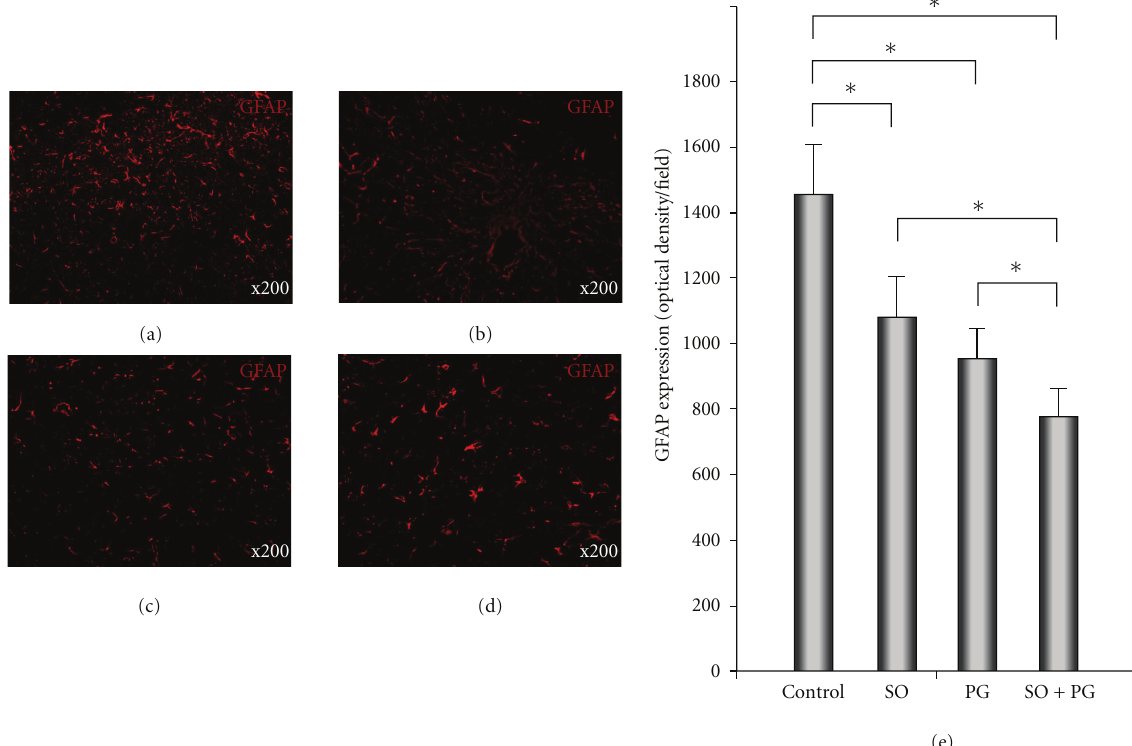
Figure 3: Quantitative analysis of immunoreactivities of GFAP at 15 days after MCAO. Histological analysis of Con (a), SO (b), PG (c), and SO + PG (d) was shown into GFAP staining at 15 days after MCAO. Quantitative immunoreactivities for all four groups are shown as bar graphs on the right side of each panel (e). The expression of GFAP in SO + PG group was significantly decreased compared with other groups. ∗ P < .